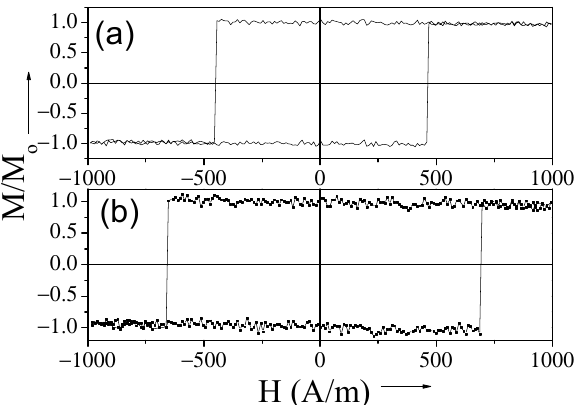
Figure 26. Hysteresis loops of as-prepared Fe 38.5 Co 38.5 B 18 Mo 4 Cu 1 microwires: sample 1 with ρ = 0.41 ( a ) and sample 2 with ρ =0.6 ( b ) measured at f = 50 Hz. (Reproduced with permission from [109] Figure 1 Copyright © 2016 Elsevier B.V).